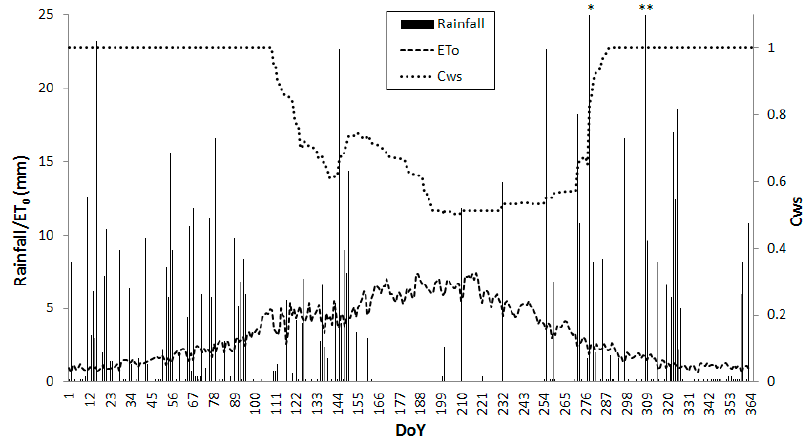
Figure 3. Daily rainfall, potential evapotranspiration and Cws derived from the interpolated meteorological data during 2013 (* and ** correspond to rainfall of 98 and 47 mm, respectively); ET 0 is computed by applying the HS method, while Cws is obtained from a simplified site water budget as described in [22,41].